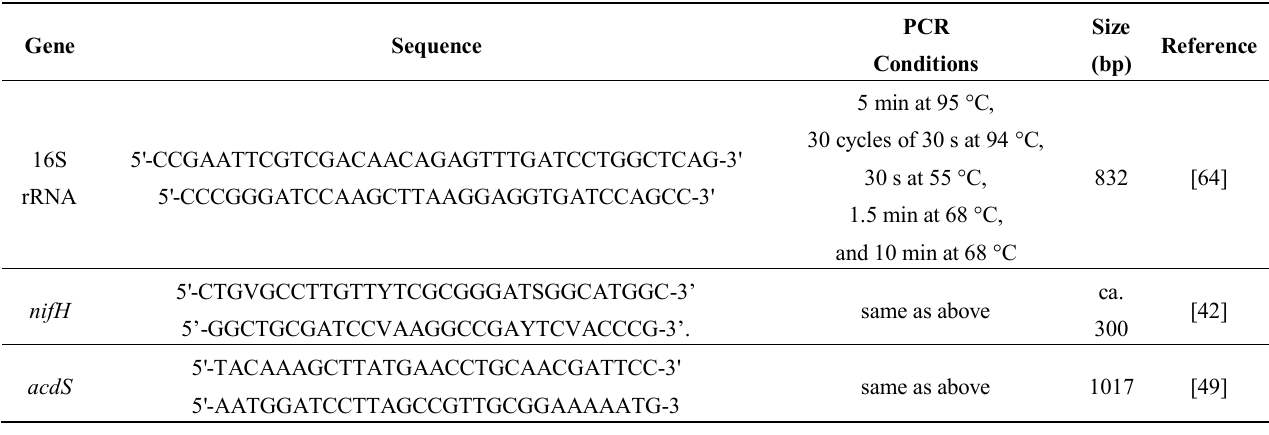
Table A1. PCR primers and conditions used in this